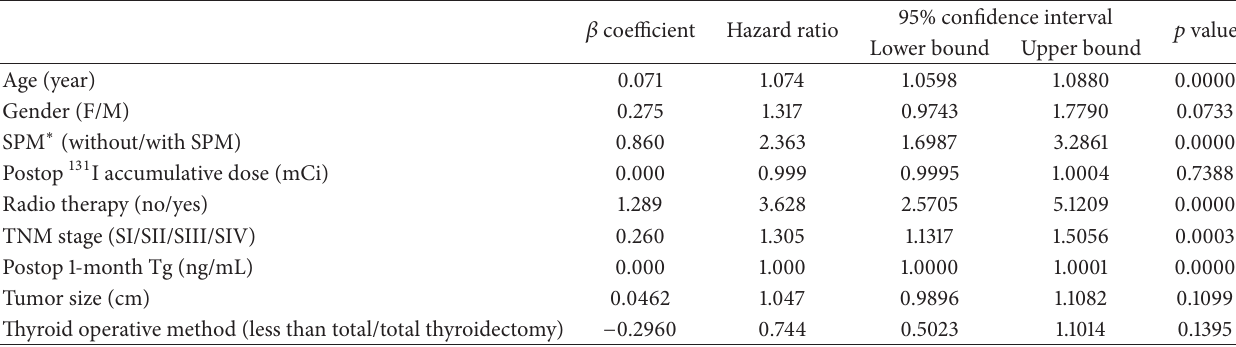
Table 2: Multivariate analysis by Cox proportional hazards regression model for survival and total mortality in 2,864 patients with well- differentiated thyroid